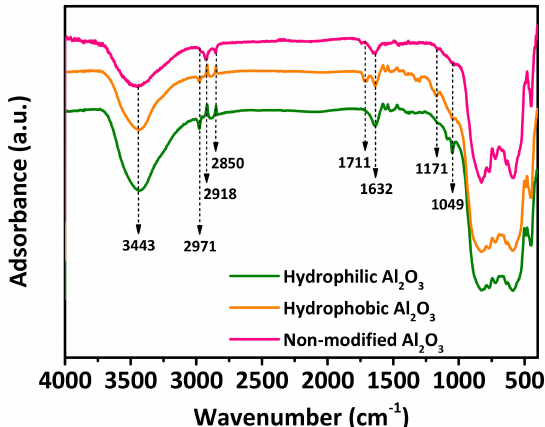
Figure 2. Fourier transform infrared spectroscopy (FTIR) spectra of non-modified, hydrophilic modified and hydrophobic modified Al 2 O 3 nanoparticles.